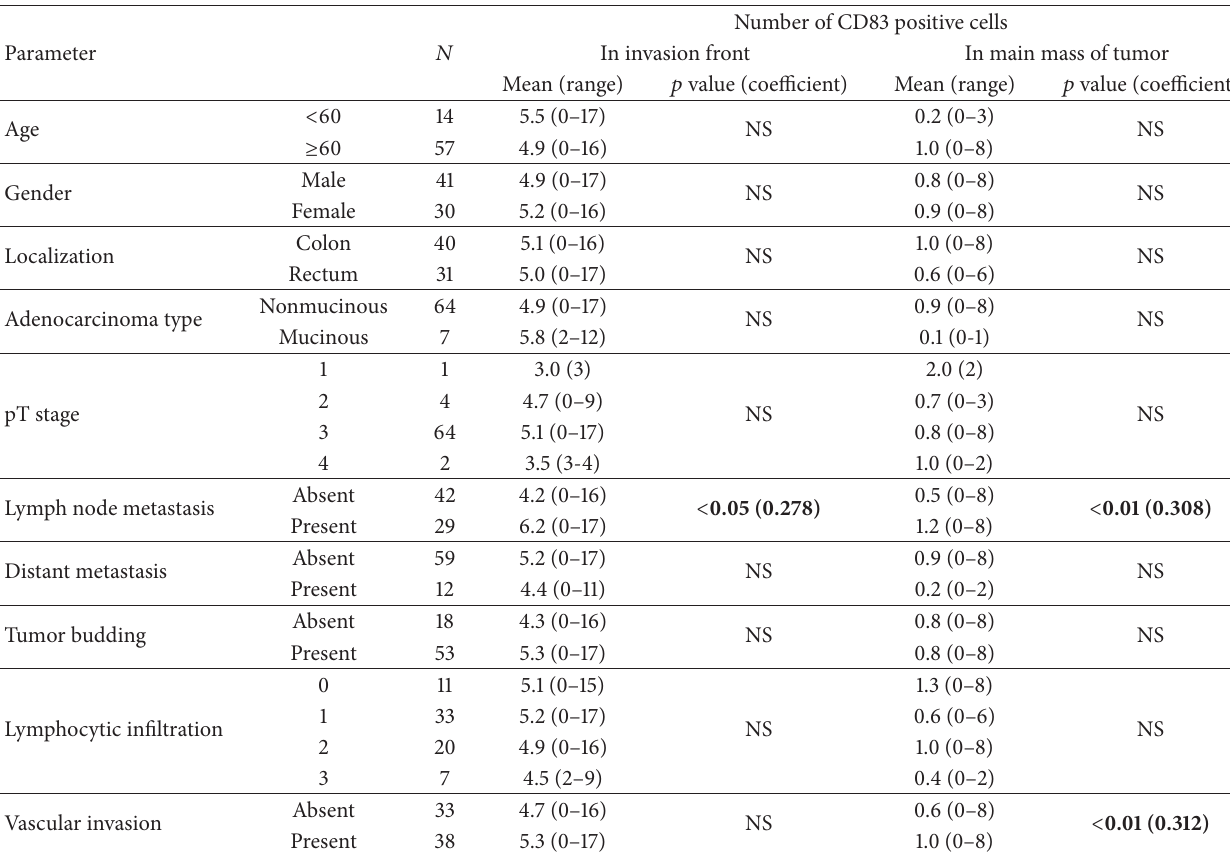
Table 2: The correlations between the number of CD83 positive cells in the front of the tumor and in the main mass of the tumor and the clinicopathological